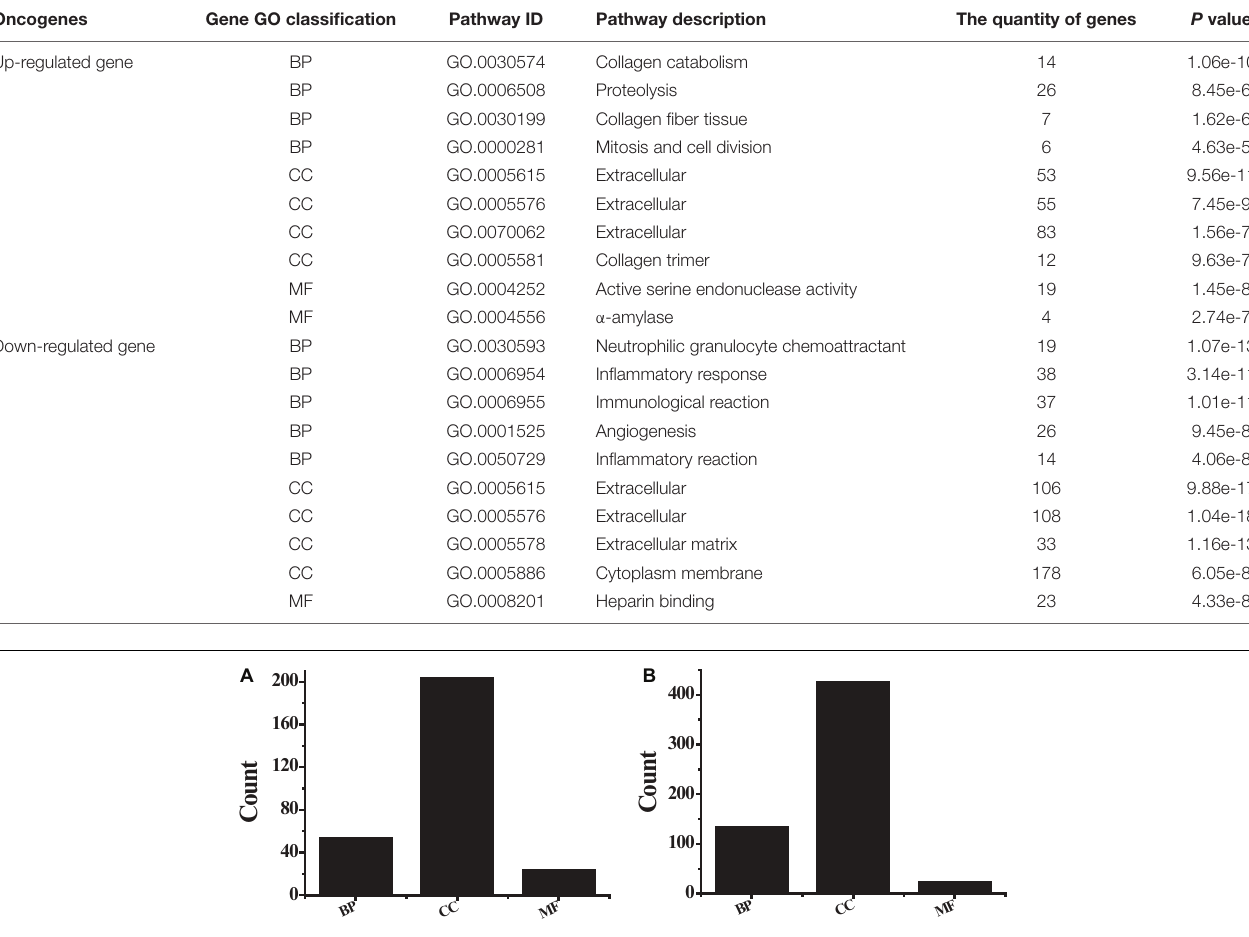
TABLE 3 | The GO analysis results of the first 10 up-regulated genes and first 10 down-regulated genes. Oncogenes